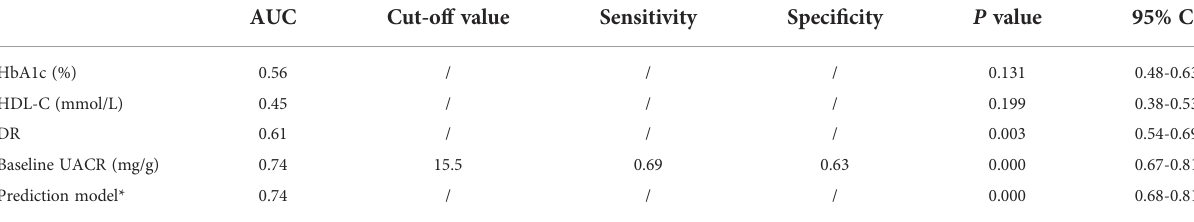
TABLE 7 The discriminative power of the predictors and the prediction model in predicting DKD. AUC Cut-off value